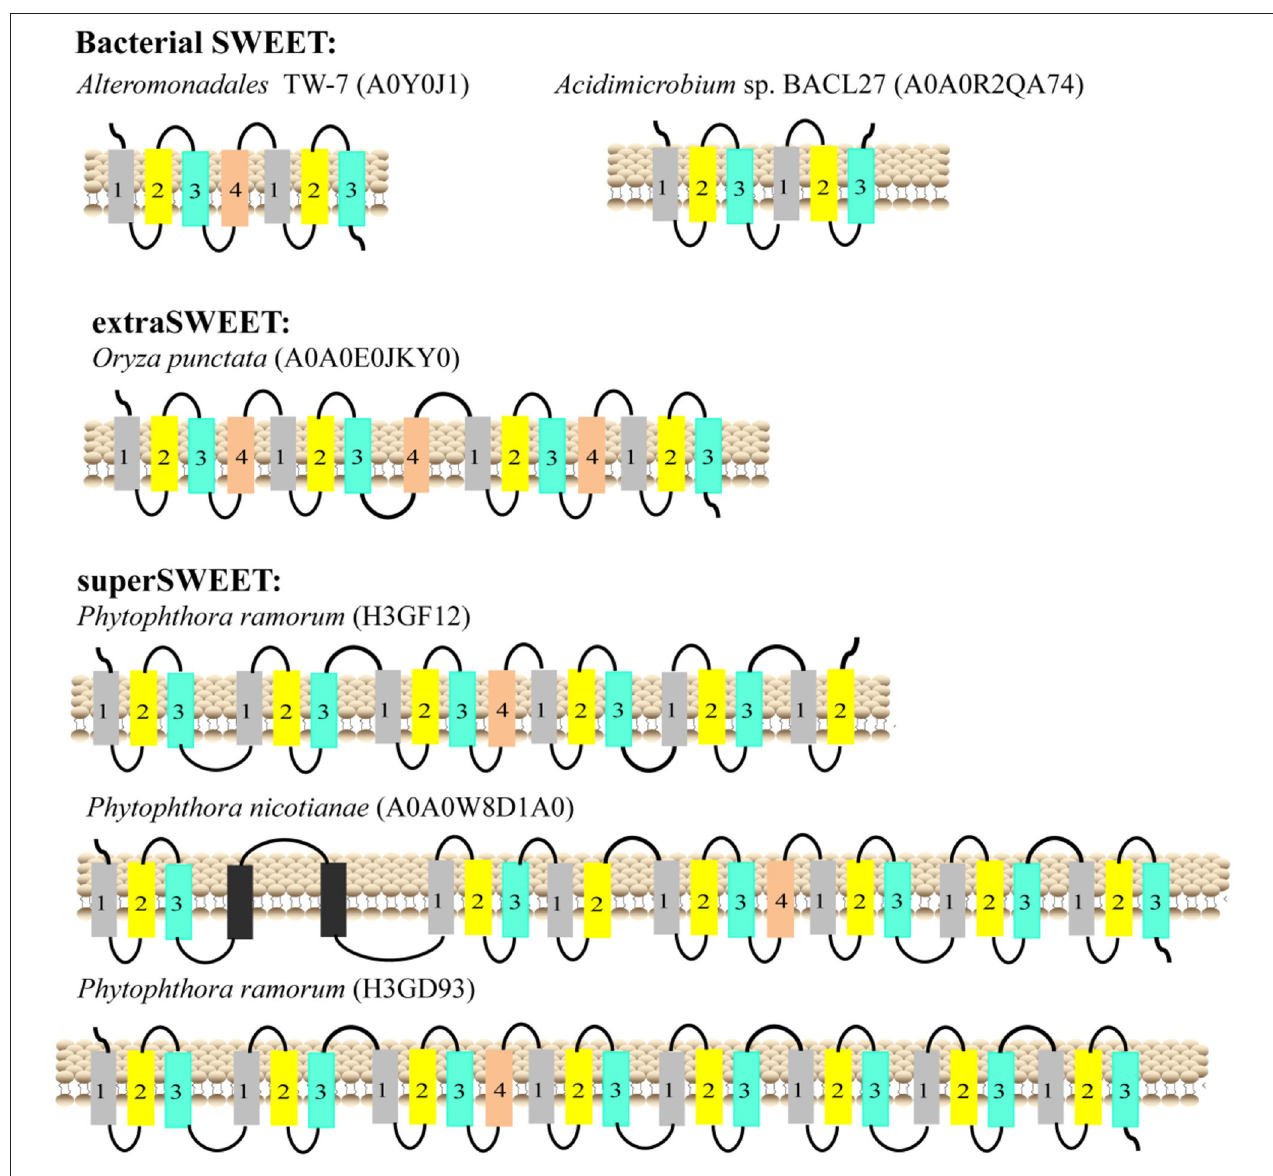
FIGURE 3 | Schematic two-dimensional model of SWEETs with multi-units characteristics from bacteria, plants, and oomycetes. TMH1, TMH2, TMH3, and TMH4 are shown in gray, yellow, blue and orange, respectively. The unknown transmembrane helix is shown in black. The origins of the proteins and their UniProt IDs are shown above the corresponding